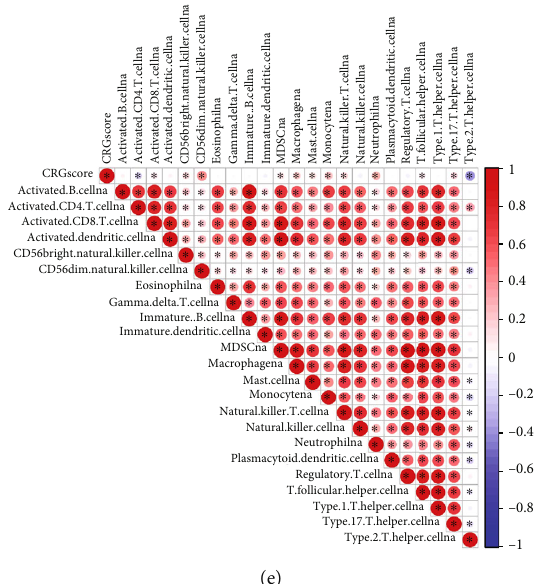
Figure 6: PCA of constructing CRG scores. (a) Survival curves in CM for patients with high and low CRG scores. (b) The Sankey diagrams of the DEG clusters and CRG scores and the distribution of survival states among the various CRG subclusters. (c) Di ff erences in CRG scores between the three CRG subclusters. (d) Di ff erences in CRG scores between the four DEG subclusters. (e) A correlation was found between the CRG scores and the invasion of immune cells in the immunological milieu of the CM. Red indicates a positive connection, whereas blue indicates a negative correlation. ∗ indicates a correlation. PCA: principal component analysis; CRG: cuproptosis-related gene; DEGs: di ff erential expressed genes; CM: cutaneous